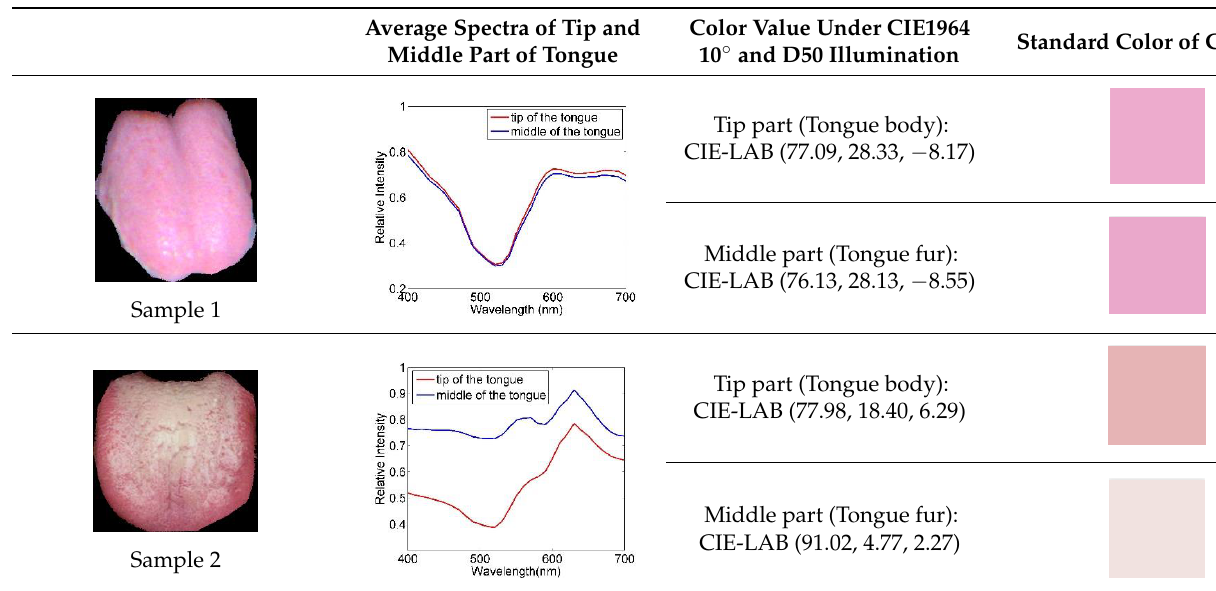
Table 2. Tongue body color and fur color of two samples.